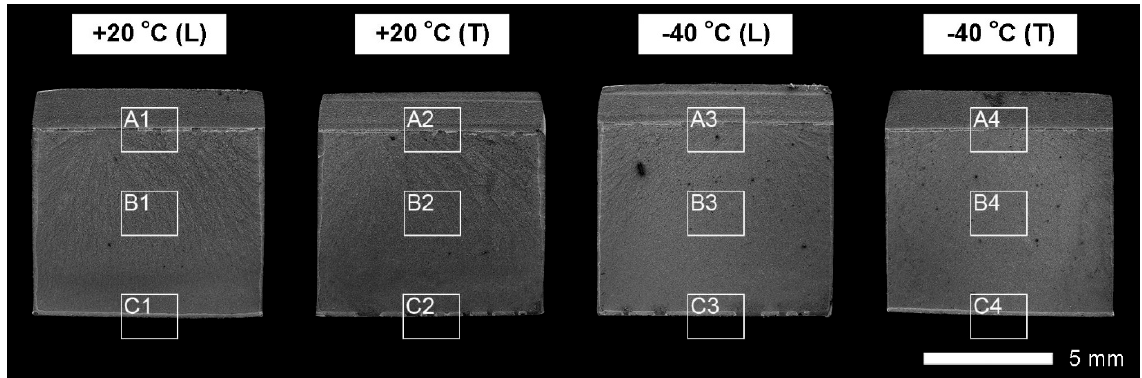
Figure 9. Macroscopic image of fractures in representative specimens of Hardox Extreme steel in delivery state: L—longitudinal orientation, T—transverse orientation; frames are used to mark: A—zone below the notch, B—central zone, C—final-fracture zone. SEM non-etched state.